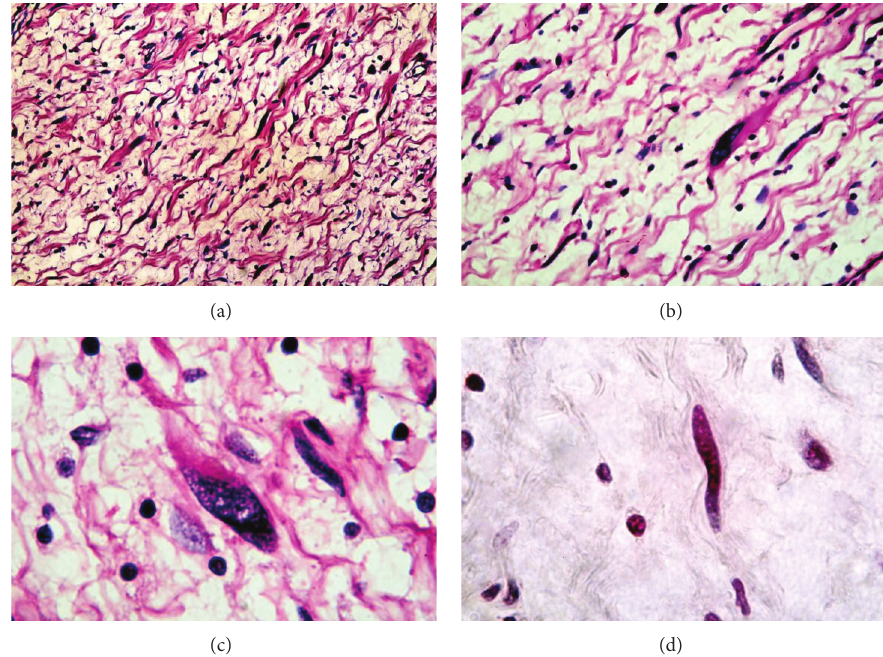
Figure 4: Malignant triton tumor showing the following: (a) well delineated spindle cells with scattered rhabdomyoblasts (H&E × 100), ((b) and (c)) higher magnification ( × 200 and × 400), and (d) cross striations of rhabdomyoblast cells stained with phosphotungstic acid hematoxylin ( × 400).